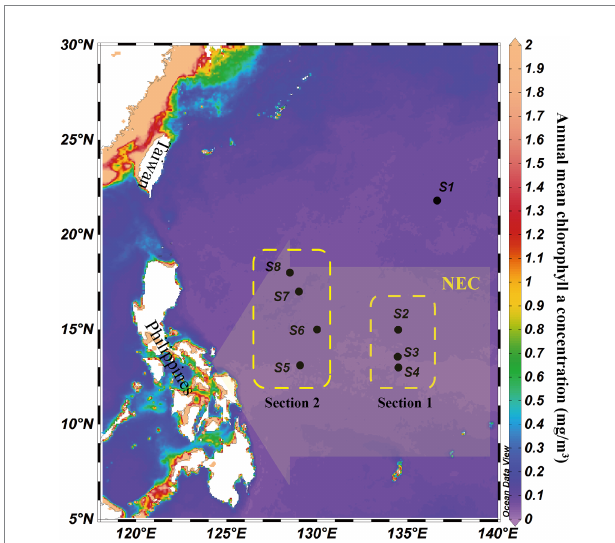
FIGURE 1 Location of eight water column sampling sites (black circles) and schematic illustration of the influence range of North Equatorial Current (NEC, yellow arrow) in the western tropical Pacific Ocean. Yellow boxes indicated two sections in the NEC influence area. The background was the annual mean chlorophyll a concentration (mg/m 3